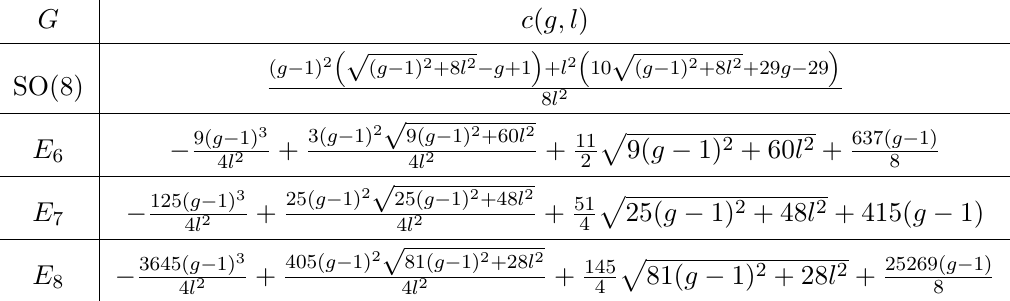
Table 5 . Value of c depending on the genus g and the U(1) (cid:13)ux l on (cid:6).